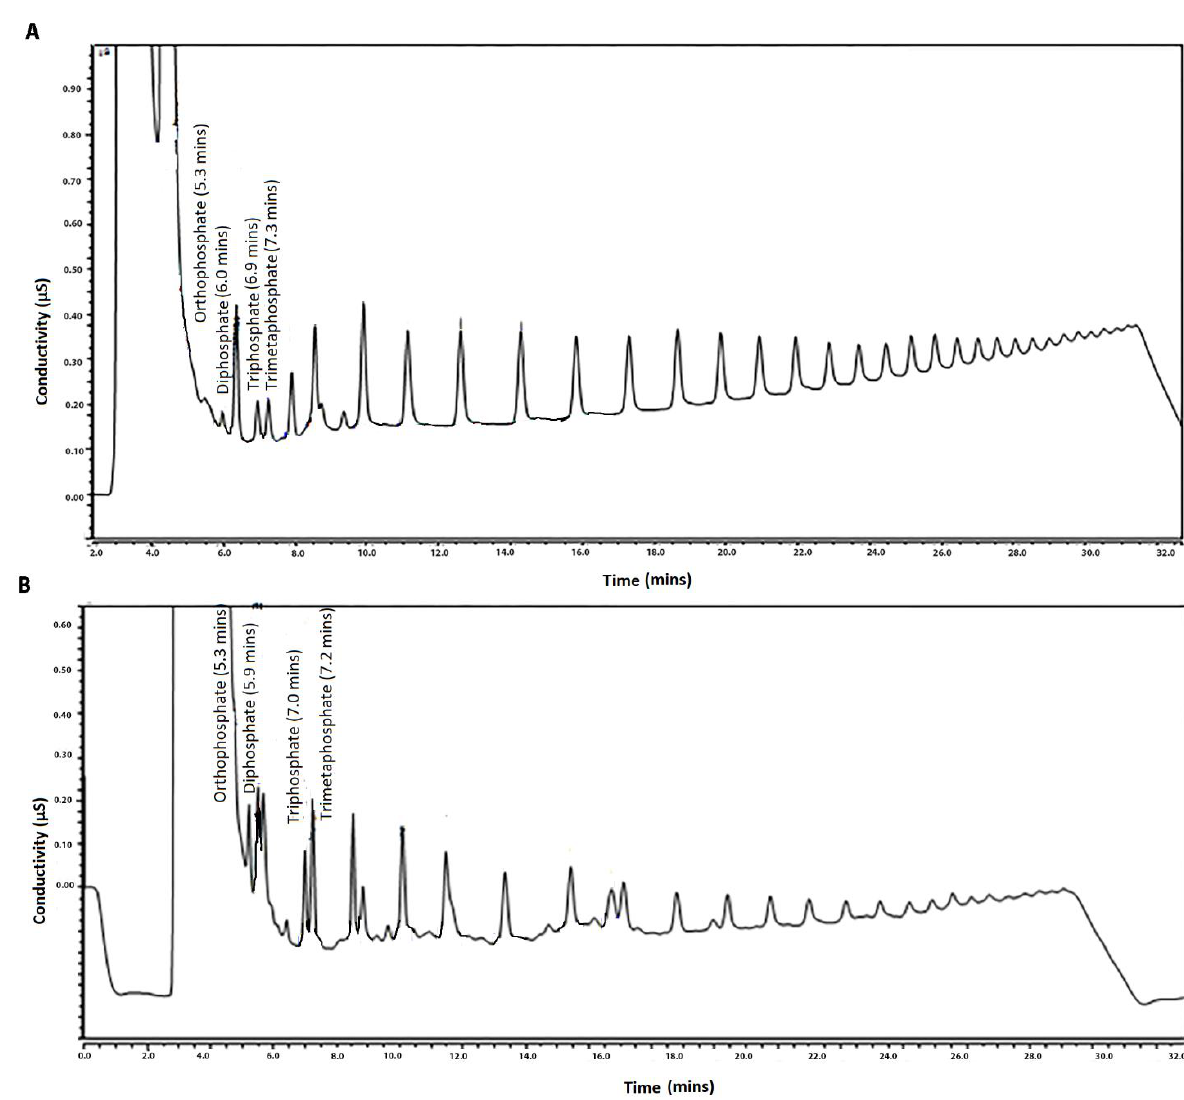
Figure 1. Chromatogram of a fish sample spiked with SHMP at level of 200 µ g g − 1 performed with ( A ) AS16 column and ( B ) AS11-HC column.